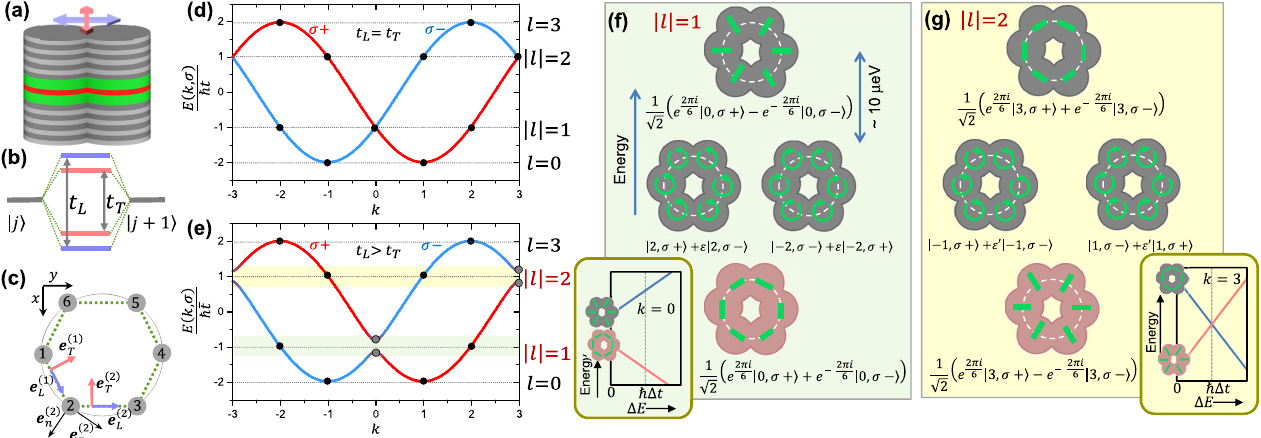
FIG. 2. Spin-orbit split states. (a) Scheme of two coupled pillars showing different tunneling probabilities for photons polarized longitudinal (light blue) and transverse (pink) to the link. (b) This results in polarization splitting of the bonding and antibonding states. (c) Scheme of the unit vectors longitudinal and transverse to each link, and radial and azimuthal on each site, used to calculate the SO-coupled eigenstates of Hamiltonian (3). (d) Polarization-dependent classification of the energy states in the absence of SO coupling ( t L ¼ t T and Δ E ¼ 0 ) as a function of their total momentum k ¼ l þ σ . States located on each horizontal line have a well-defined orbital momentum l and form degenerate multiplets. (e) Same as (d) for t L ≳ t T . The SO coupling is evidenced in the anticrossing of the bands, at k ¼ 0 and k ¼ 3 . (f) – (g) Fine structure and polarization pattern of the molecular eigenstates corresponding to the multiplets l ¼ 1 (f) and l ¼ 2 (g), split by the SO coupling for ℏ Δ t > Δ E . Note that ϵ ; ϵ 0 ≪ 1 (see Sec. I of Ref. [32]). The salmon color shows the states in which condensation takes place in Figs. 4 and 5. The insets in (f) and (g) show the relative energy of the top and bottom states of each multiplet when Δ E > 0